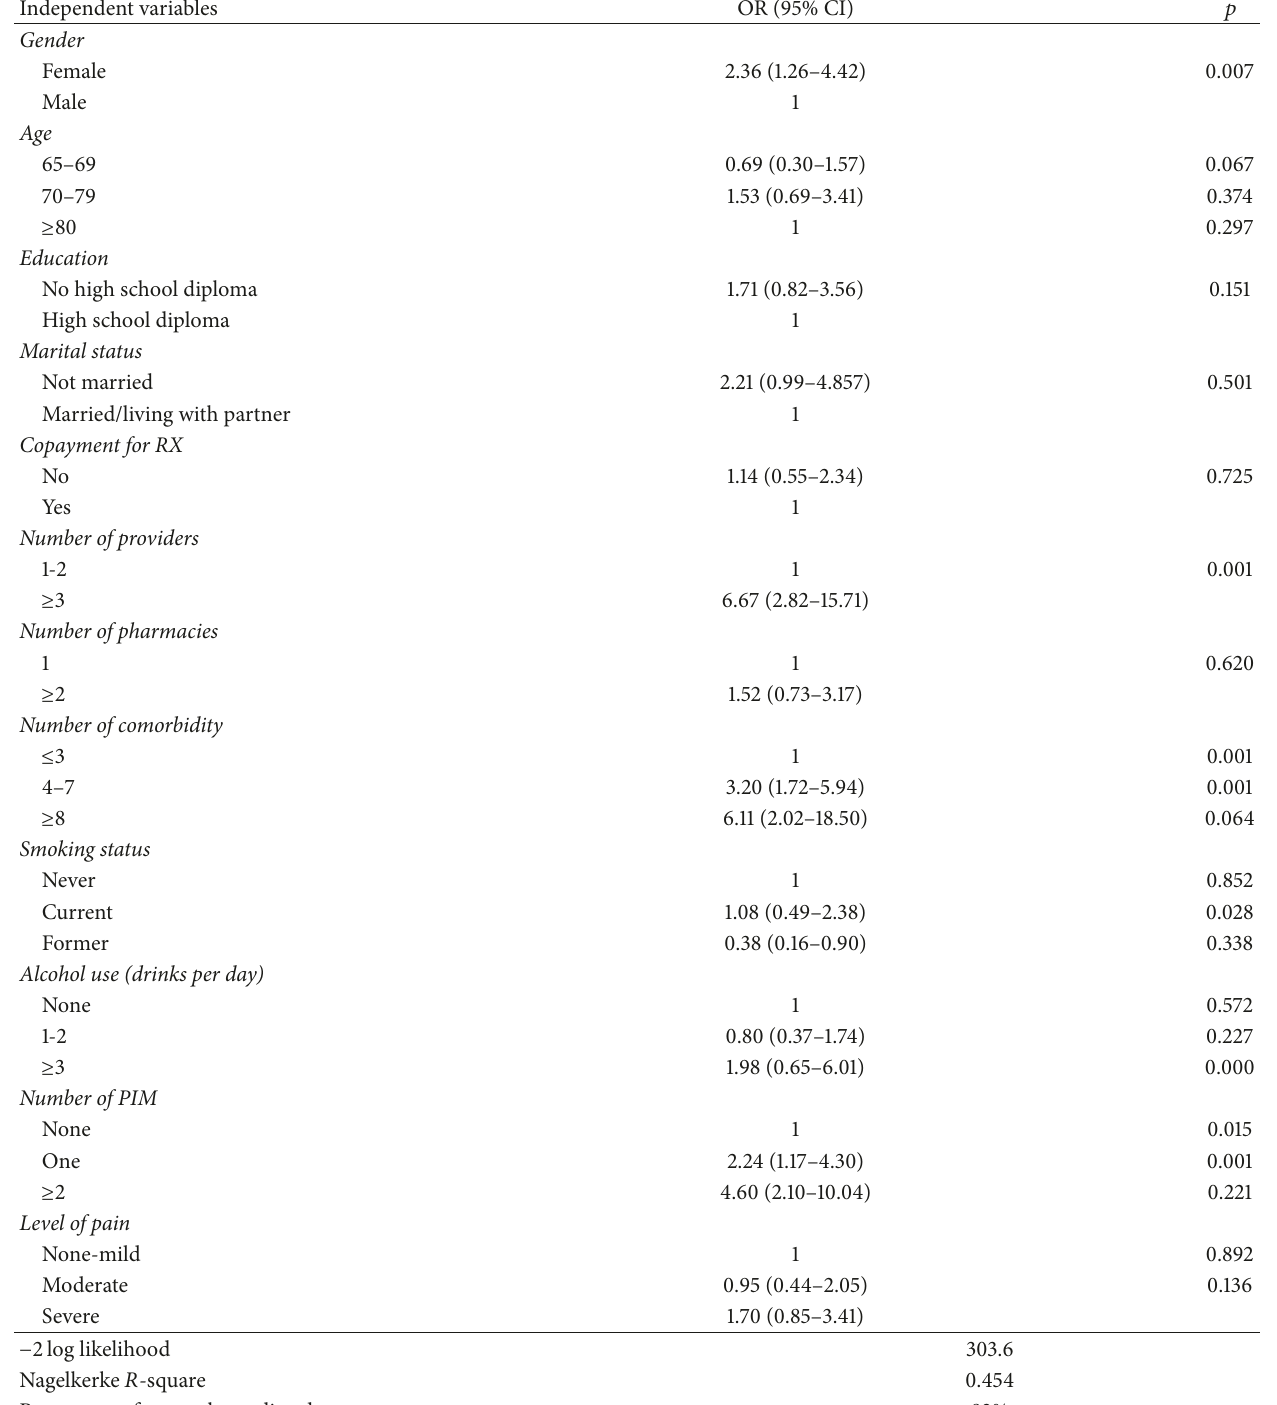
Table 2: Multivariate logistic analysis of correlates of use of high versus low medication use ( 𝑁 = 400 ). Independent